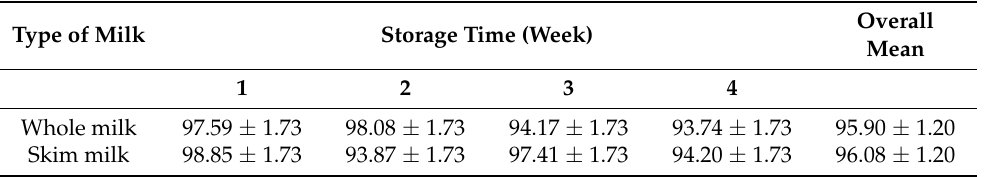
Table 3. Stability of fucoxanthin based on percent recovery 1 in goat whole and skim milk during storage at refrigeration temperature (4 ◦